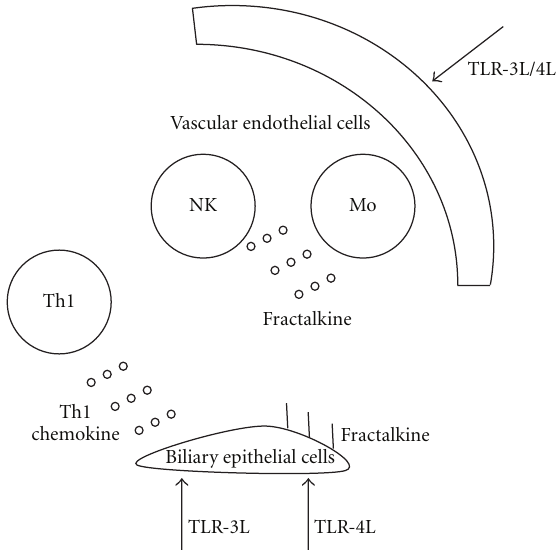
Figure 4: The proposed role of fractalkine is illustrated. TLR3 or TLR4 ligands stimulate vascular endothelial cells to produce fractalkine as chemokine, then fractalkine attracts CX3CR1 positive monocytes or NK cells. Subsequently, TLR4 ligand stimulated BEC produce fractalkine as cell adhesion molecule, then fractalkine recruit CX3CR1 positive cells around PBC target cells. This starts the chronic nonsuppurative destructive cholangitis and perpetuates the autoimmune pathogenesis of disease. Finally, TLR3 ligand stimulated biliary epithelial cells produce Th1 chemokines, and these chemokines are considered to contribute this autoimmune mechanism.